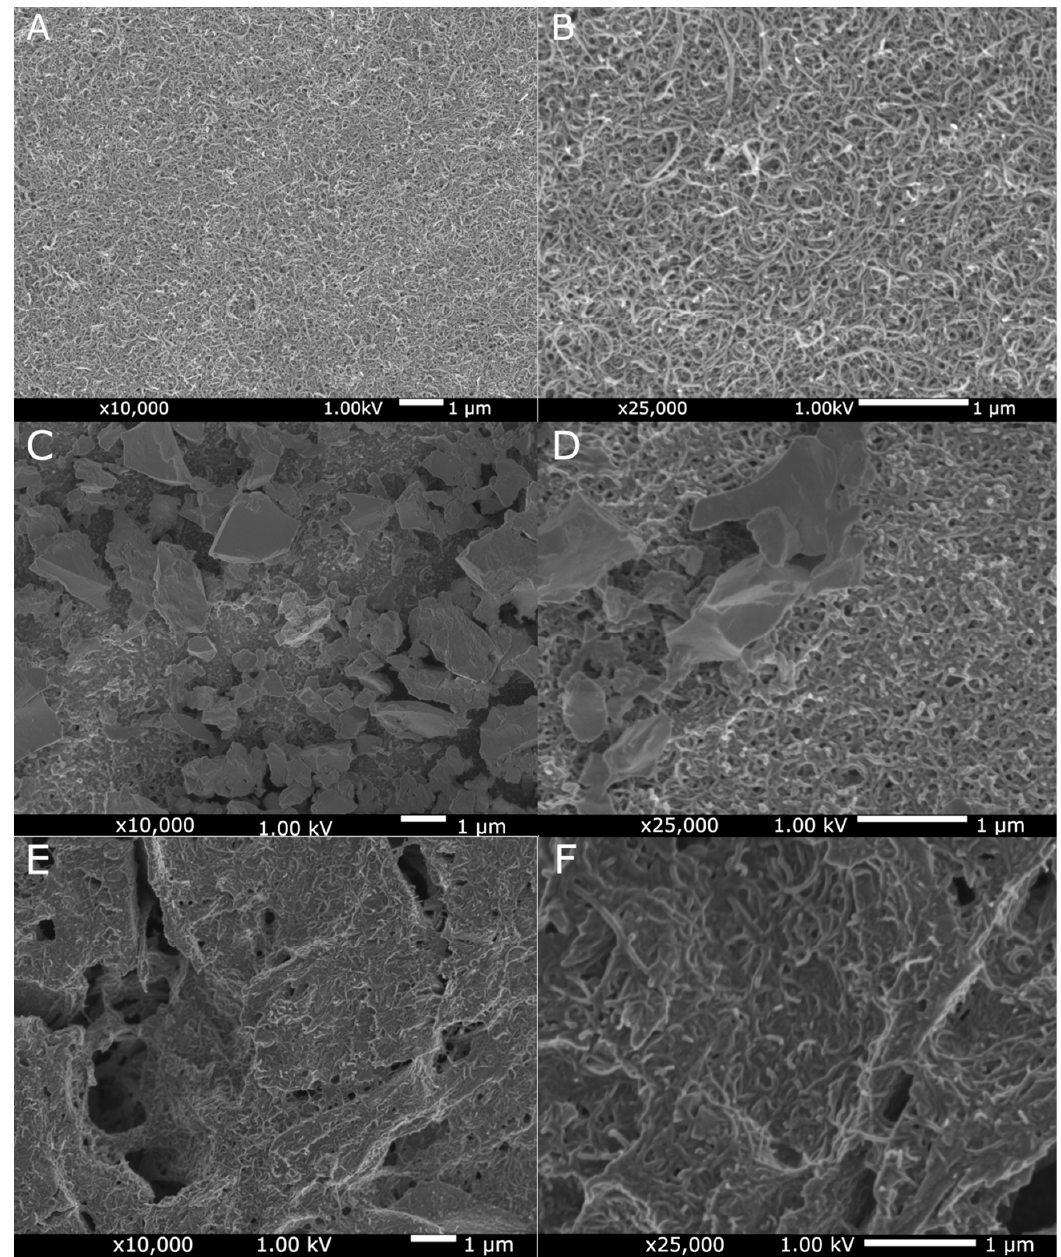
Figure 2. SEM surface topography of the MWCNTs coating ( A , B ), the MWCNTs/TiO2 bi-layer coating ( C , D ) and the MWCNTs_Cu dispersion coating ( E , F ) in different resolutions.